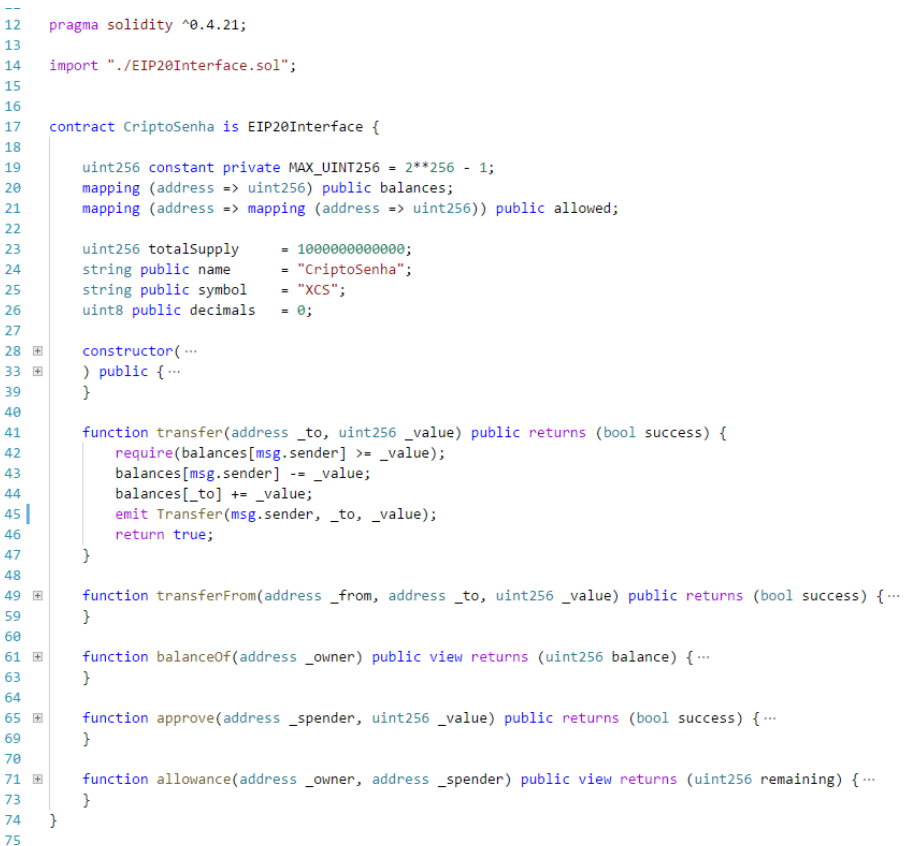
Figure 15. The Smart Contract developed for CriptoSenhas.